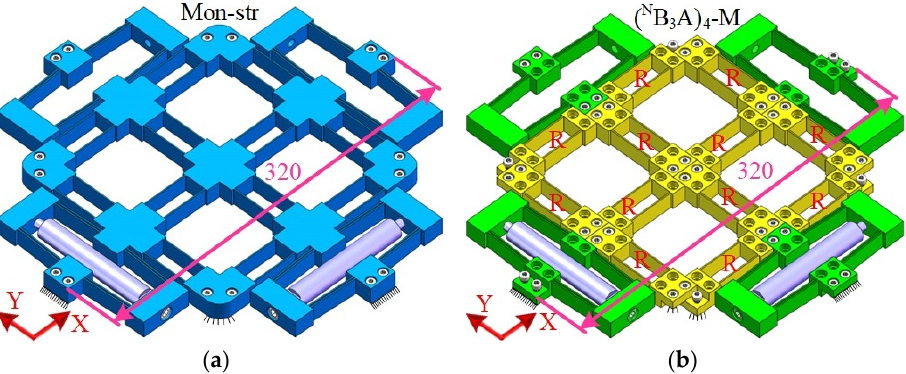
Figure 12. Two decoupled parallel XY MPSs. N and M are determined by the modules and materials of R, respectively; (a) monolithic XY stage; (b) modular XY stage. Table 2. The properties of materials.